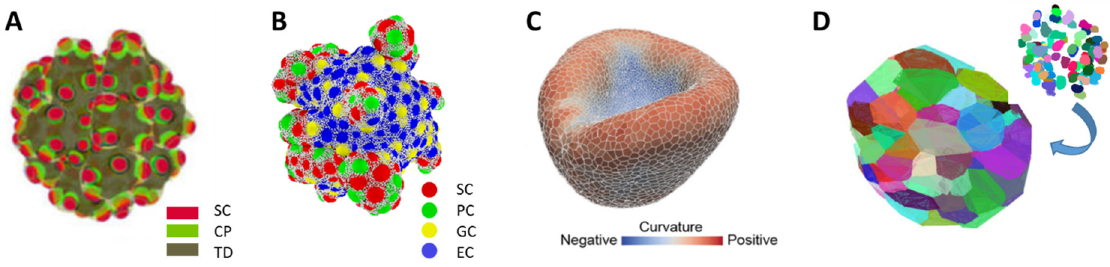
Figure 1. Methods for modelling 3D cell aggregates. ( A ) Continuum model of a colon cancer organoid [10]. Colors indicate the density of different cell types. SC: stem cell, CP: committed progenitor, TD: terminal differentiated cell. ( B ) Individual cell-based model of an intestinal organoid [11]. Cells are represented by overlapping spheres. Colors indicate different cell types. PC: Paneth cell, GC: goblet cell, EC: enterocyte. Cell motion is confined by a polymer network enveloping all cells (grey). ( C ) Vertex model of an optical-cup [12]. Cells are represented by prisms that form a dense surface. ( D ) 3D Voronoi tessellation of a tumor spheroid [13]. The cell shape is derived from the neighborhood relations of experimentally detected cell centers (upper right). Individual cells are indicated by different color. Table 1. Different 3D COM approaches (compare also Norfleet et al. [9]).